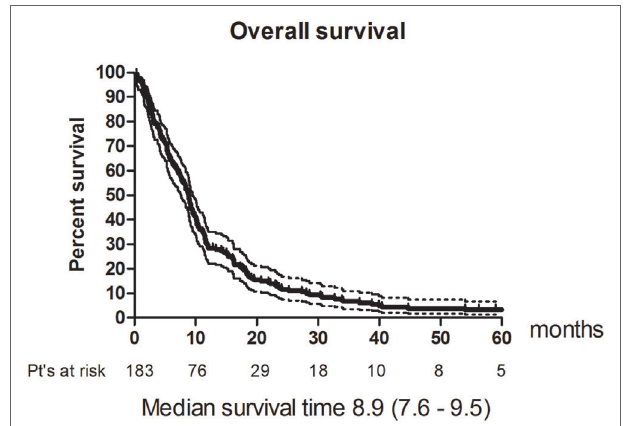
FiGUrE 1 | Overall survival for the study population. N = 183.